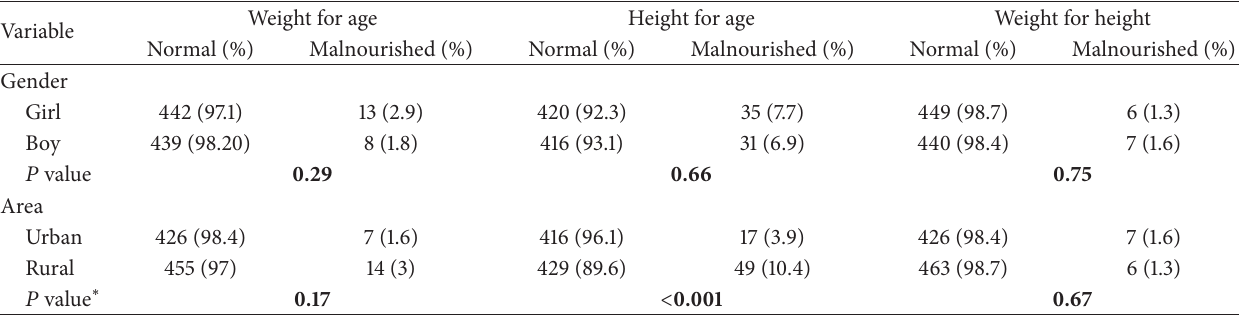
Table 4: Comparison of status and proportion of malnourished children by gender and region in